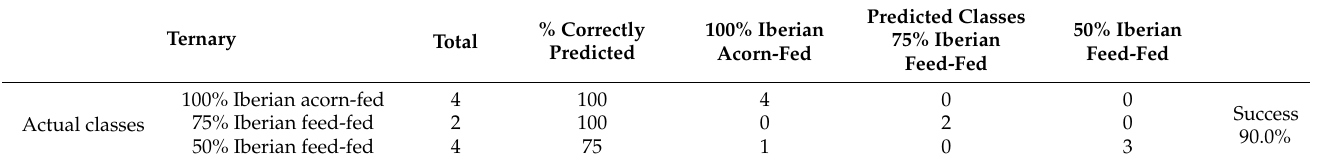
Table 4. Results of ternary Raman chemometric classification model with device